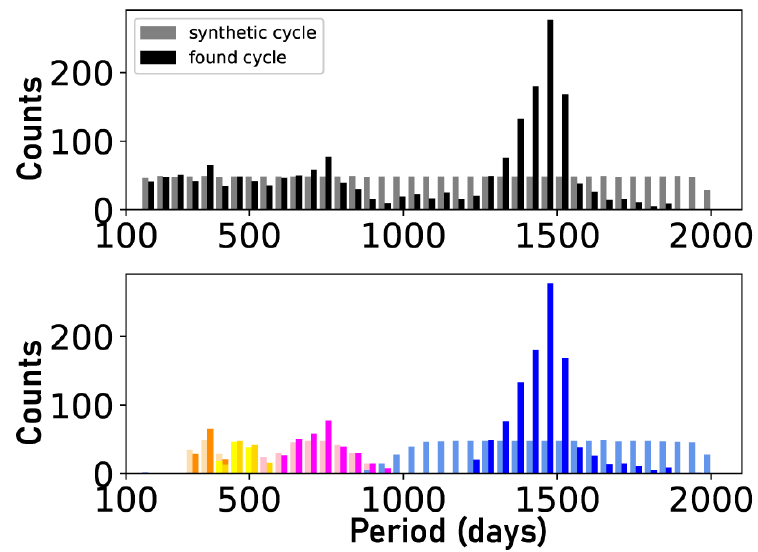
Figure 9. Both panels: lighter colors are the distribution of synthetic periods (input cycle) and darker colors are the output cycles recovered by our smoothness metric when applied to an ∼ 4 years segment. The top panel shows what will happen if the real cycles have a uniform distribution. The bottom panel is the same as the top, except the cycle periods staying in the same period bin have been excluded. The periods staying in the same period bin means that the input and output periods are in reasonable agreement. The four color pairs in the bottom panel highlight the peaks in the top